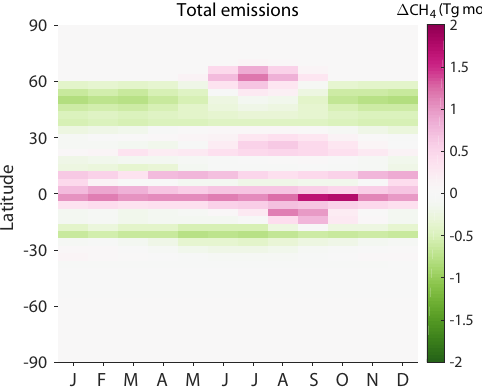
Figure B1. Monthly averages of the difference in total CH 4 emis- sions between the base and aseasonal GEOS-Chem simulations, summed over each zonal band, in Tgmo − 1 .